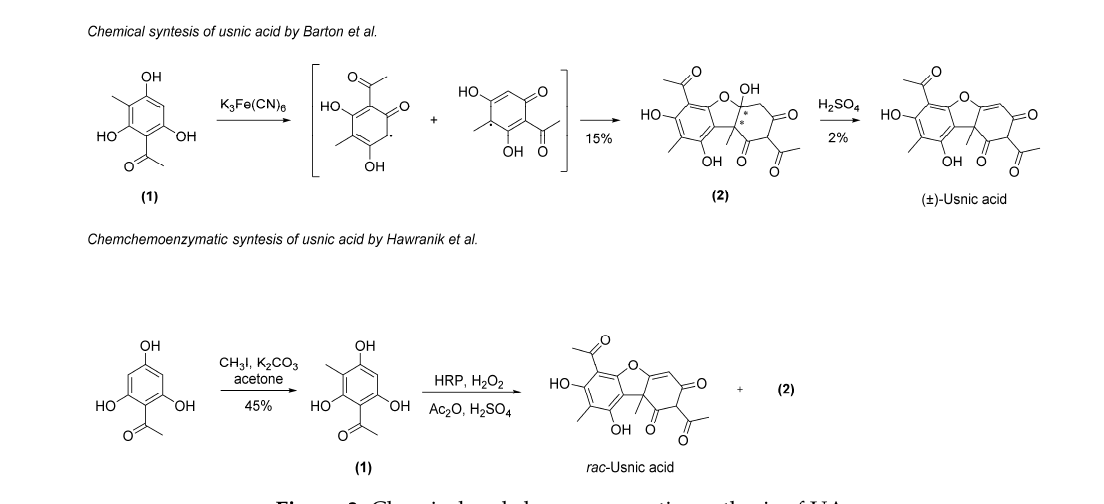
Figure 3. Chemical and chemoenzymatic synthesis of UA.